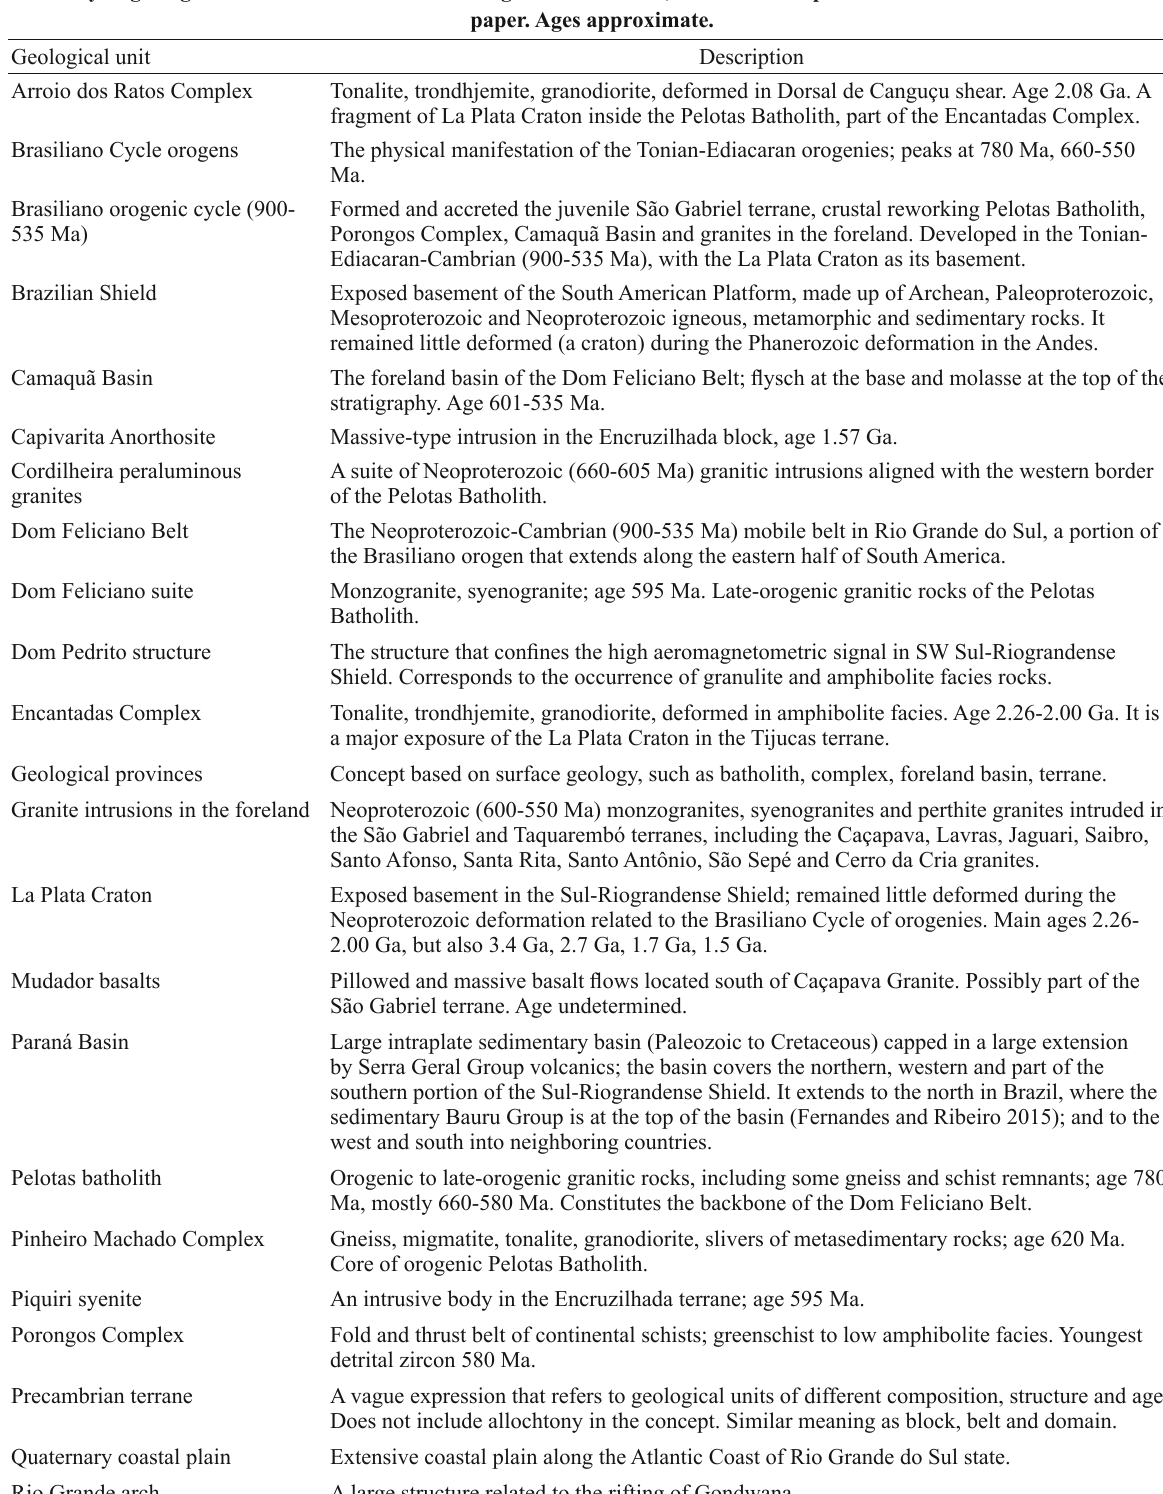
Glossary of geological nomenclature of the Sul-Riograndense Shield, based on interpretation of studies mentioned in this paper. Ages